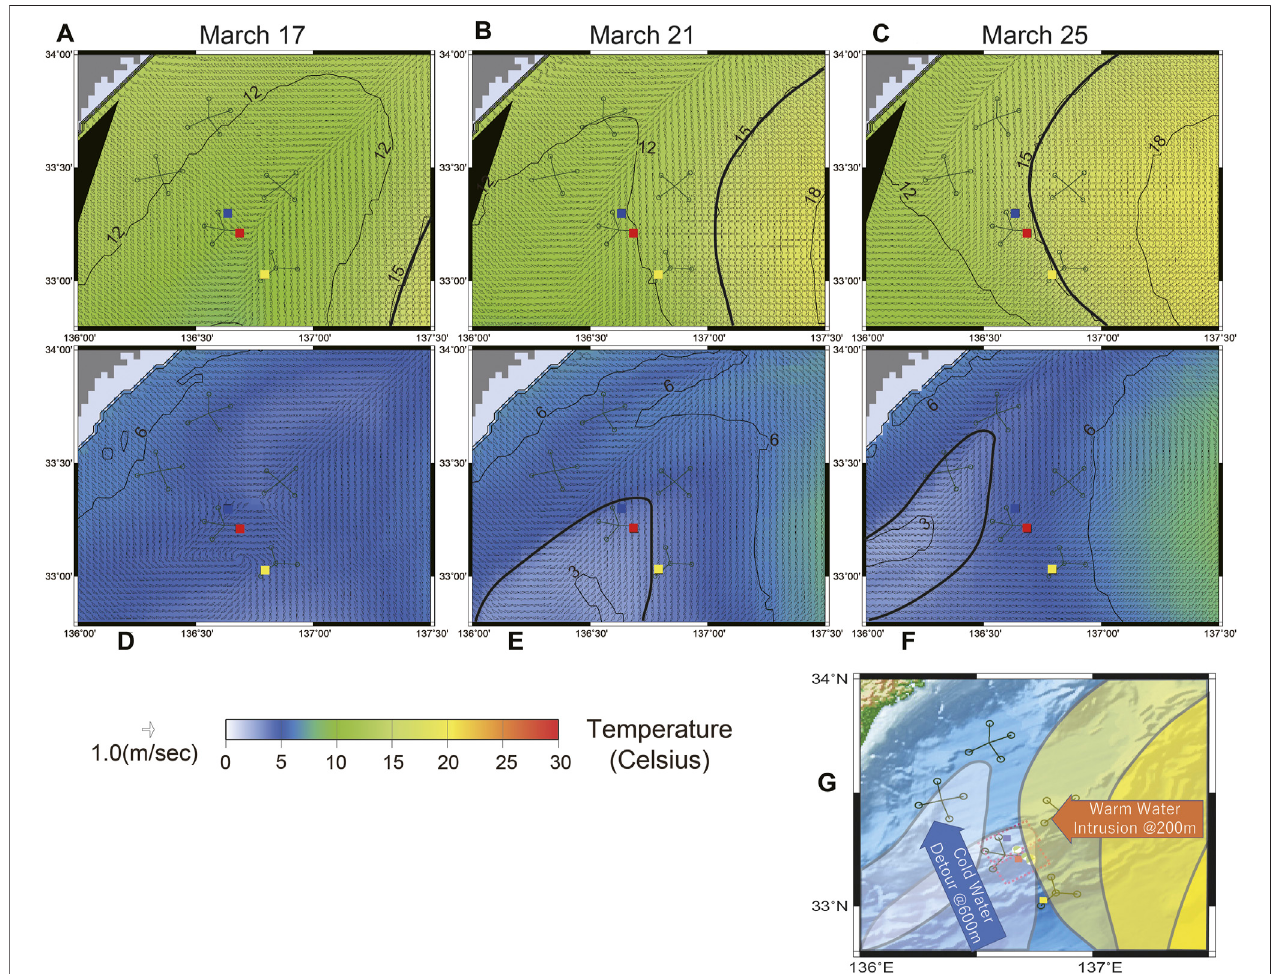
FIGURE 12 | Ocean temperature with current vector at the depths of (A – C) 200 and (D – F) 600 m under the sea surface with isothermal contours (3 ° ). Circles and squaresrepresentDONETandboreholestations,respectively. (G) SchematicillustrationoftheS-shapedmeanderingpatternbytracingisothermalcontoursof15and4 ° at the depths of 200 and 600 m as shown by bold curves in (A – F) . Target region is the same as Figure 1A .